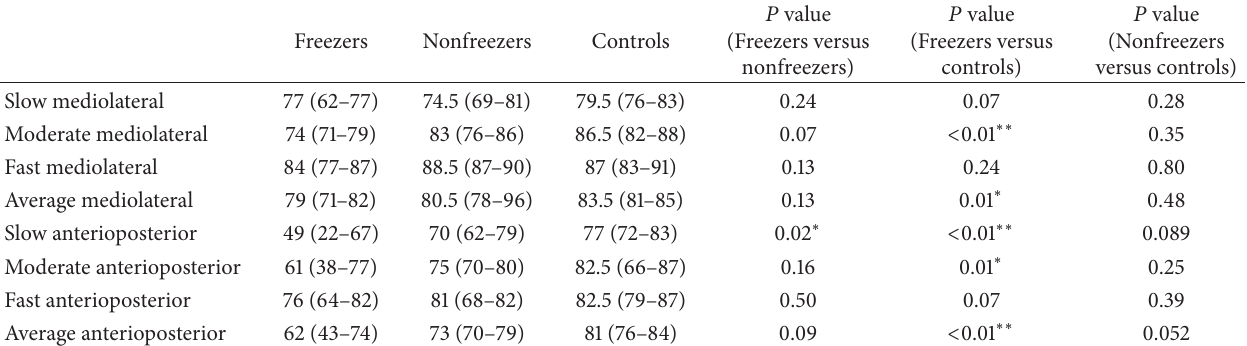
Table 3: Directional control during rhythmic weight